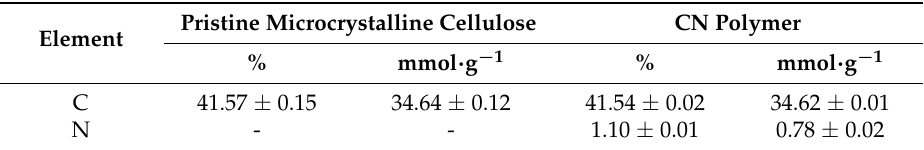
Table 1. Percentage of carbon and nitrogen from the polymer and the respective numbers of moles from pure and modified (CN)